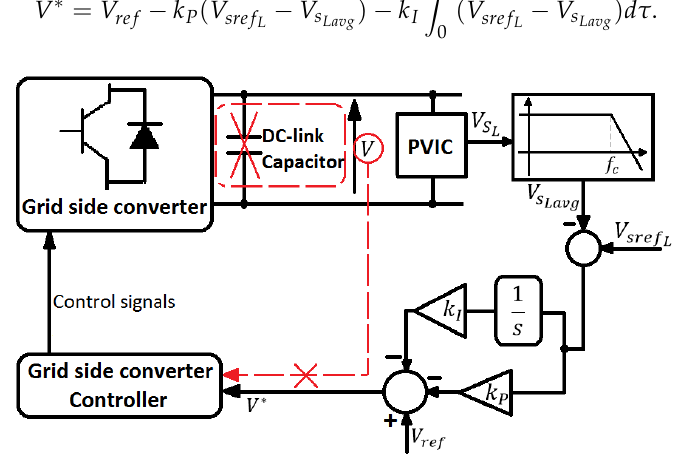
Figure 5. Charge control scheme of the LF-VIC. The estimated voltage V ∗ replaces the measurement of the DC-link voltage for the grid side